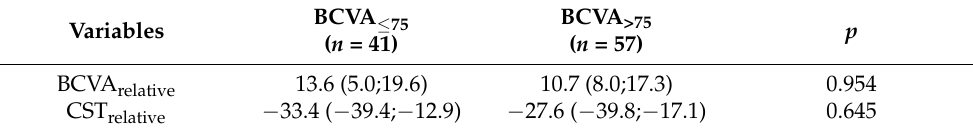
Table 7. Comparison of BCVA relative and CST relative in the BCVA ≤ 75 group ( n = 41) and the BCVA >75 group ( n = 57) of patients with diabetic macular edema. The results are presented as median